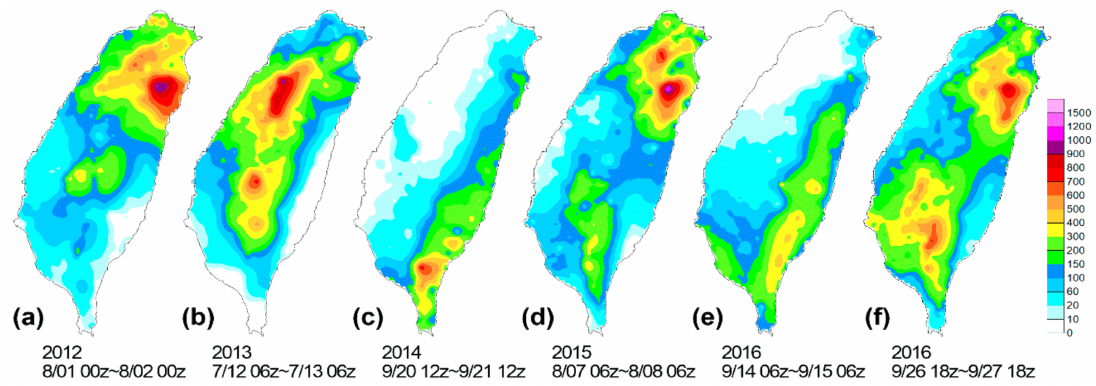
Figure 5. Observed maximum 24 h rainfall of ( a ) Saola; ( b ) Soulik; ( c ) Fung-Wong; ( d ) Soudelor; ( e ) Meranti; and ( f )